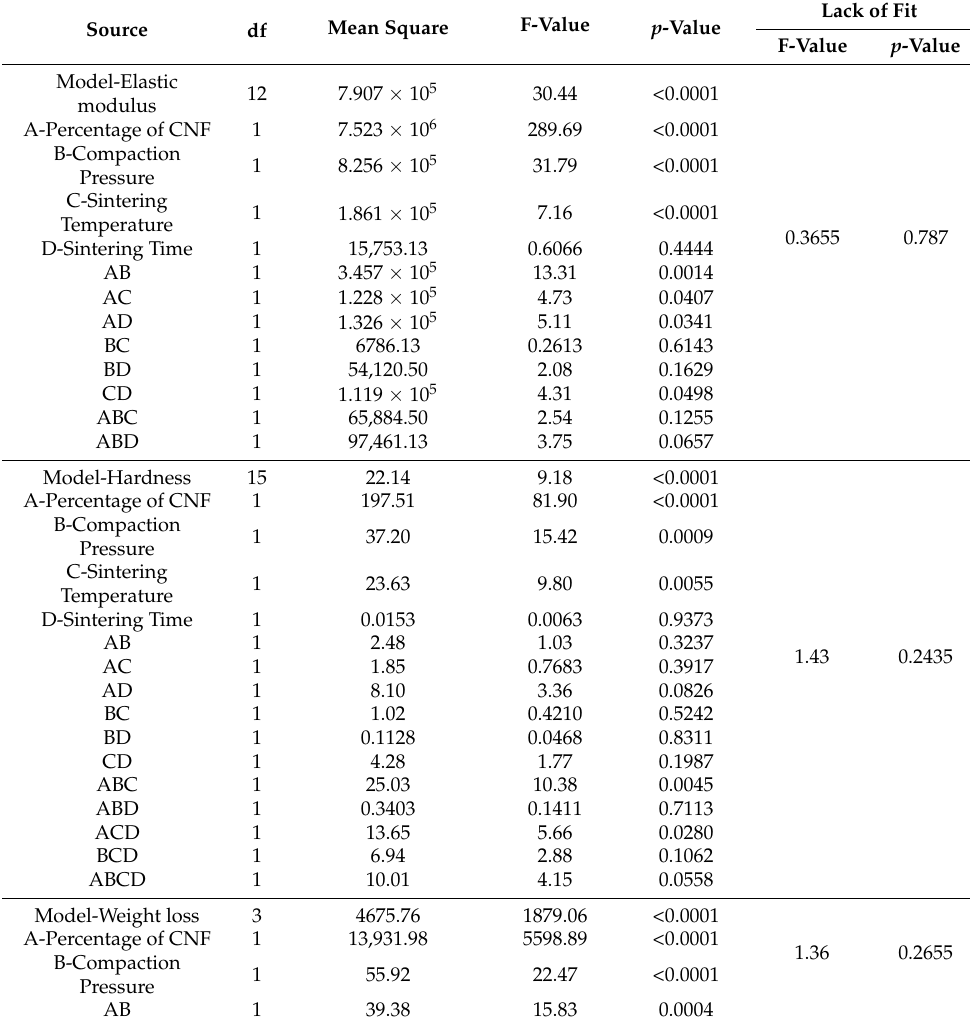
Table 3. ANOVA for elastic modulus, hardness, and weight loss.